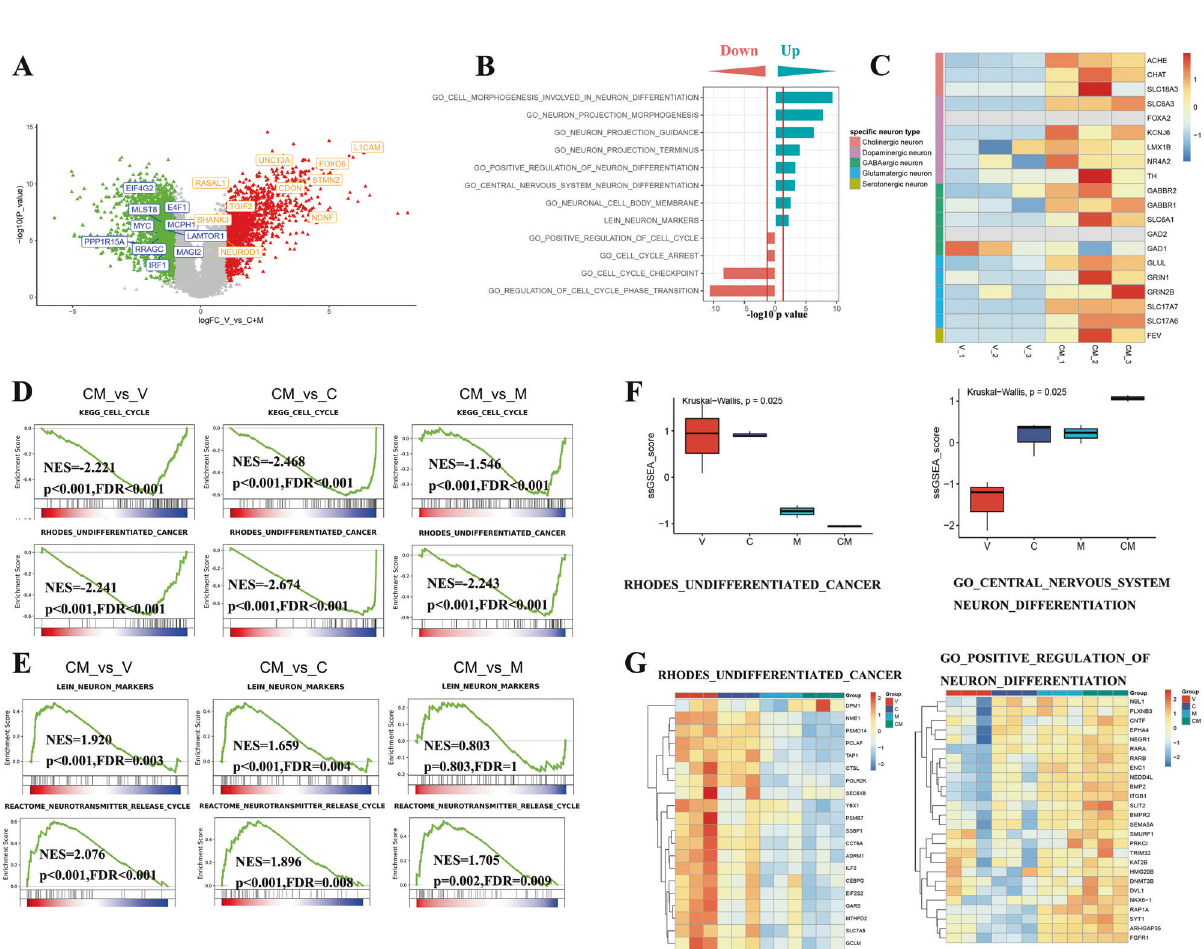
Fig. 3 Transcriptomics analysis reveals that 8-CPT-cAMP and MS275 synergically induce GBM cells differentiation. A Volcano plot showing the changes in gene expression of U87MG cells treated with V or CM for 2 days. The gene symbols with orange/blue represent typical genes related to neuron-differentiation/oncogenesis. B Gene set enrichment analysis (GSEA) comparing V- and CM-treated U87MG cells. C The heatmap of speci fi c neuron biomarkers in V- and CM-treated U87MG cells. D , E GSEA analysis of cell cycle/undifferentiation gene sets ( D ) and neuron marker/neurotransmitter gene sets ( E ). P < 0.05 and FDR < 0.05 were considered as signi fi cant. F Single sample GSEA (ssGSEA) analysis of V-, C-, M-, and CM-treated U87MG cells. Kruskal – Wallis test was used to determine the signi fi cance of differences between groups. G Heatmap of gene sets of undifferentiation-related genes and neuron differentiation-related genes. V, Vehicle (1 ‰ DMSO); C, 0.5 mM 8-CPT- cAMP; M, 1 μ M the severity of the disease (Fig. 5I, J and Tab S3), and has a higher predictive value for classifying the WHO grade of glioma than the individual scores (Fig. 5K).